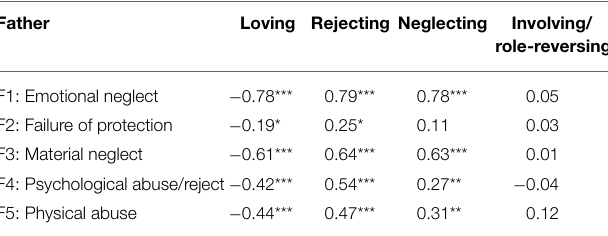
TABLE 5 | Correlations with AAI scales for inferred experiences with father.